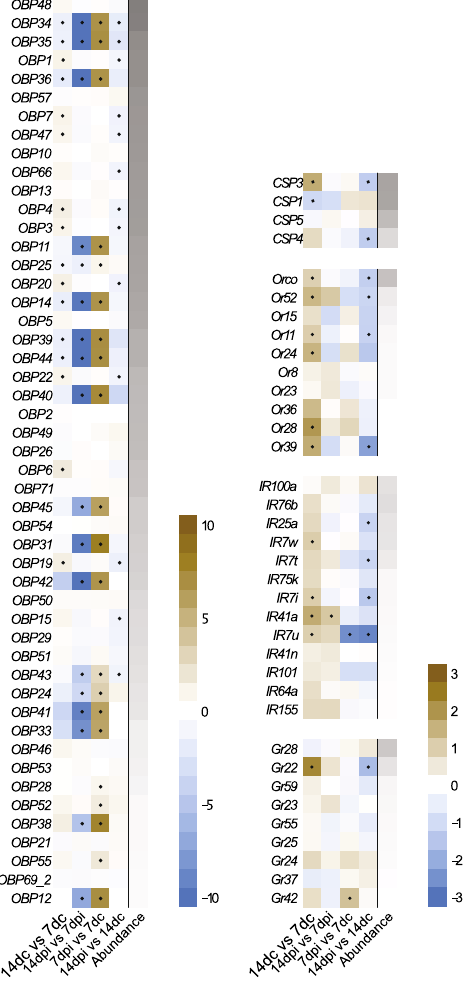
Figure 4. Antennal chemosensory transcript abundance in female Anopheles gambiae is affected by Plasmodium falciparum infection stage. Chemosensory transcripts demonstrating reliable expression (> 1 TPM) in the antennae of midgut oocyst-infected (7 days post-infection; dpi) and salivary gland sporozoite-infectious (14 dpi) female mosquitoes, along with their age-matched controls (7 days control; 7dc and 14 dc) were analysed in pairwise comparisons displayed as log 2 fold change in abundance. Chemosensory genes are arranged into gene families, odorant binding proteins ( OBP s), chemosensory proteins ( CSP s), odorant receptors ( Or s), ionotropic receptors ( Ir s) and gustatory receptors ( Gr s), in descending order of abundance (grey gradient bar, log 10 TPM). Significant differences in abundance (fold change > 2; FDR-corrected p < 0.05) are indicated by black